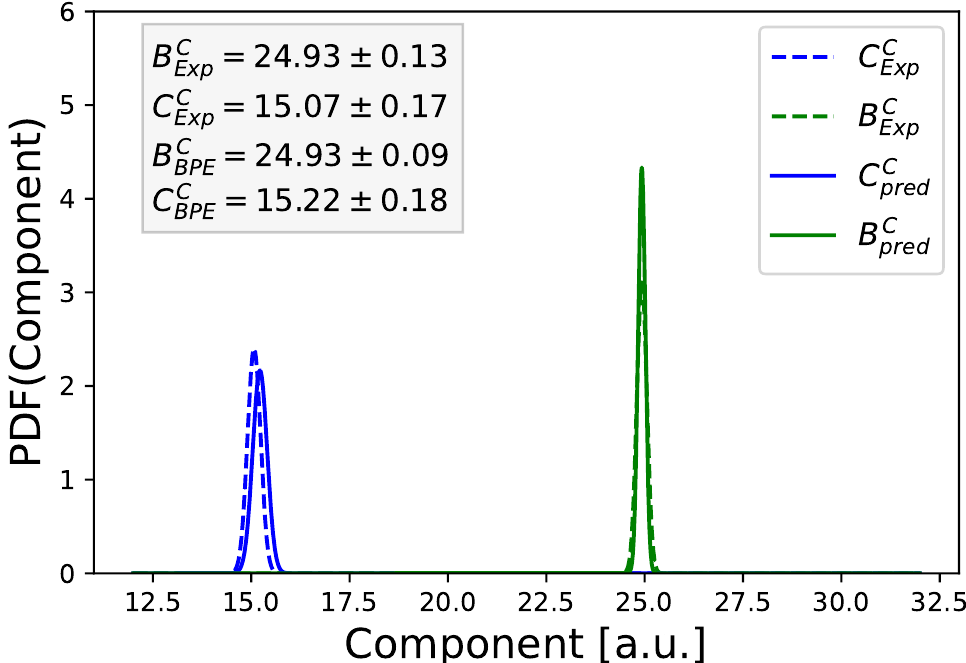
Figure 4. Posterior distributions of B C (green solid curve) and C C (blue solid curve) from Bayesian pred pred predictive ensemble calculations for coupled unit operations. The corresponding observed values are shown as dashed curves. More details can be found in the main text. All units are